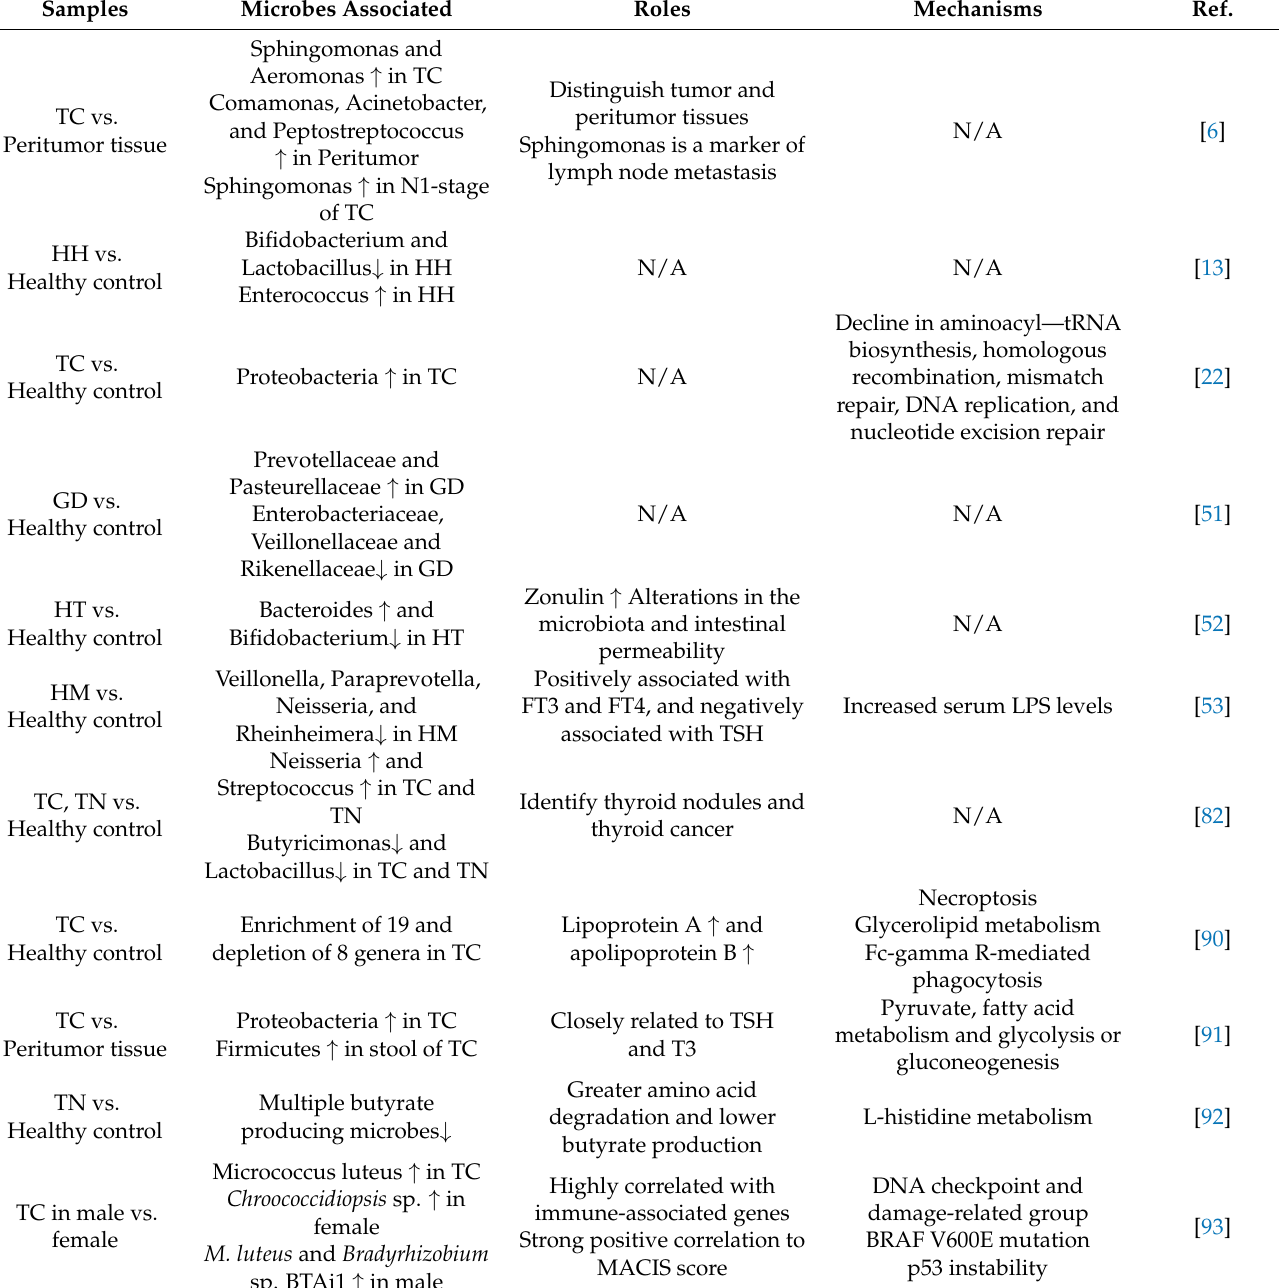
Table 1. Microbiota differences in thyroid diseases and thyroid